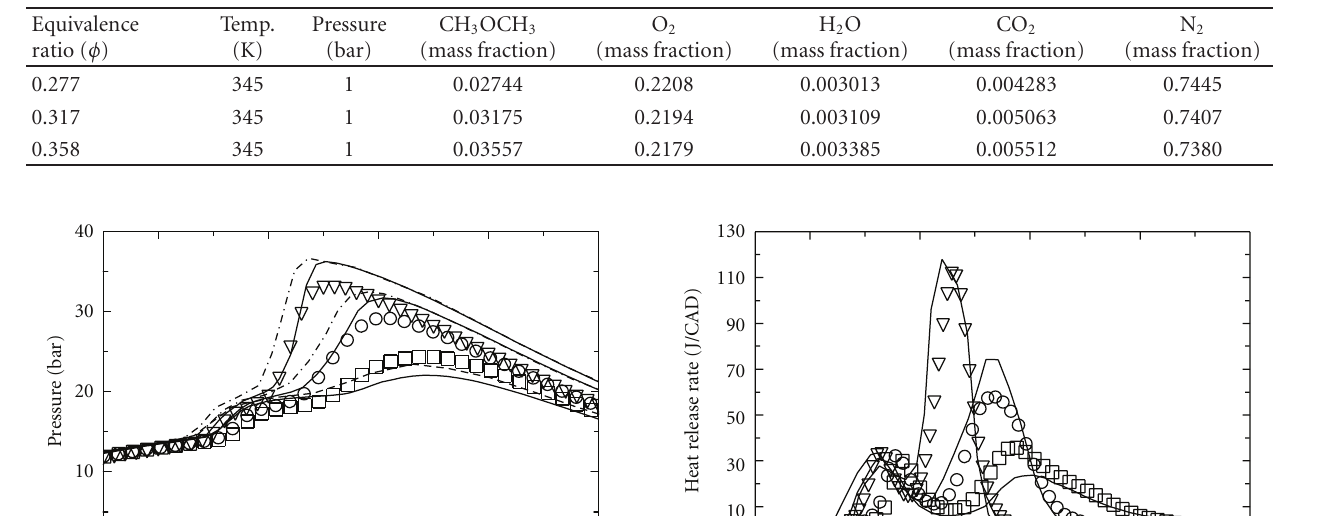
Table 4: Initial conditions at bottom dead center used in 3-D CFD engine simulations.